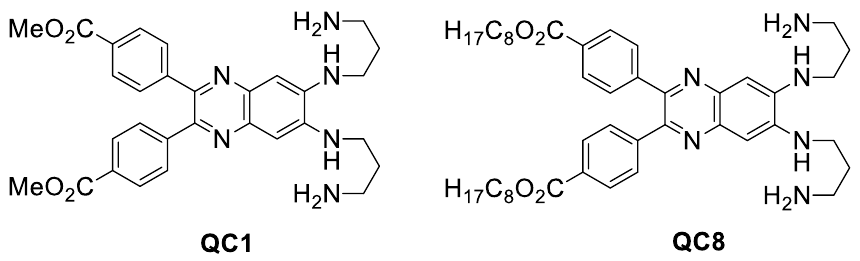
Figure 1. Structures of studied aminoquinoxalines QC1 and QC8 .